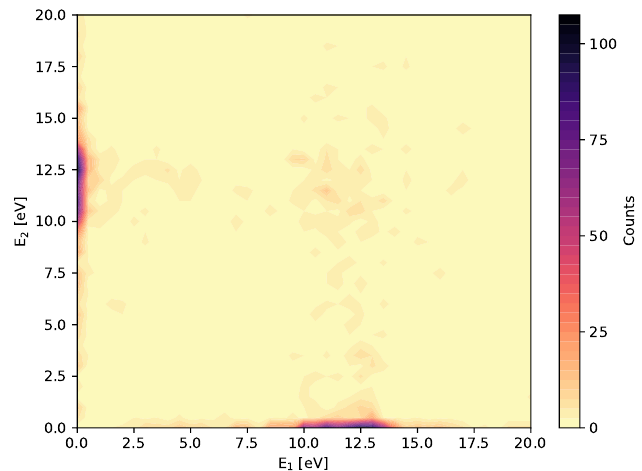
Figure 4. Two-dimensional kinetic energy spectrum of photoelectrons originating from the same laser pulse in two-photon double ionization (TPDI) in argon. The clustering at low E 1 and low E 2 are the signature of the sequential double ionization (SDI) channel. The blob on the diagonal is caused by false coincidences. Reproduced and modified from